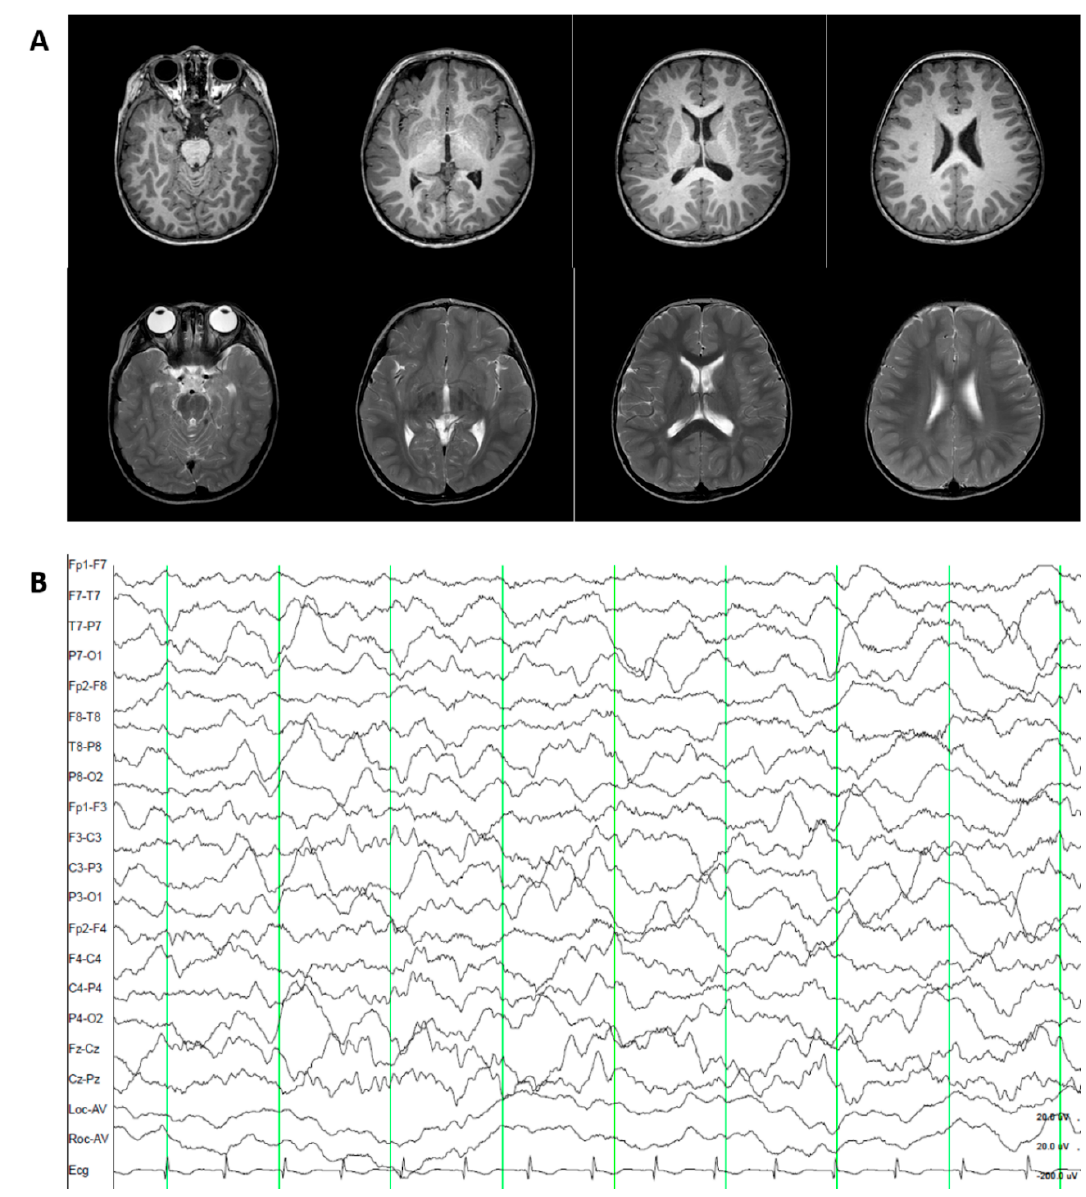
Figure 3. Brain MRI and EEG finding of patient 4 at 2 years. ( A ) The T1 (first row) and T2 (second row) images were normal. ( B ) The EEG was normal.